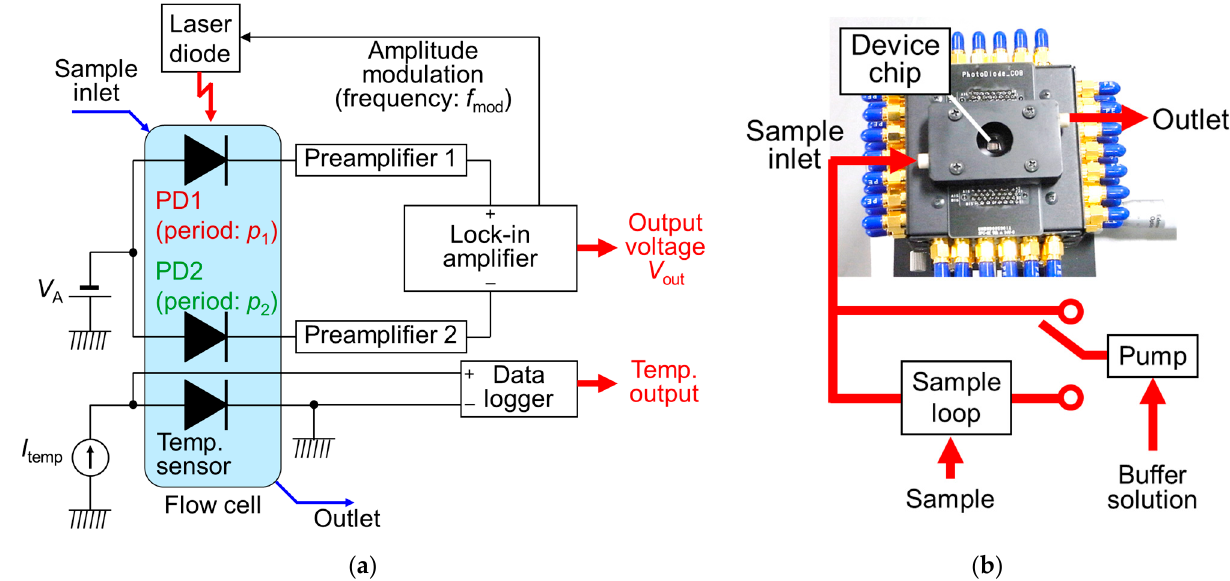
Figure 8. ( a ) Measurement circuit for single-wavelength dual photodiode (PD) method; ( b ) evaluation box to operate PDs with sample flow system. Packaged device chip is mounted on evaluation box, and inlet of coverage is connected to flow system.